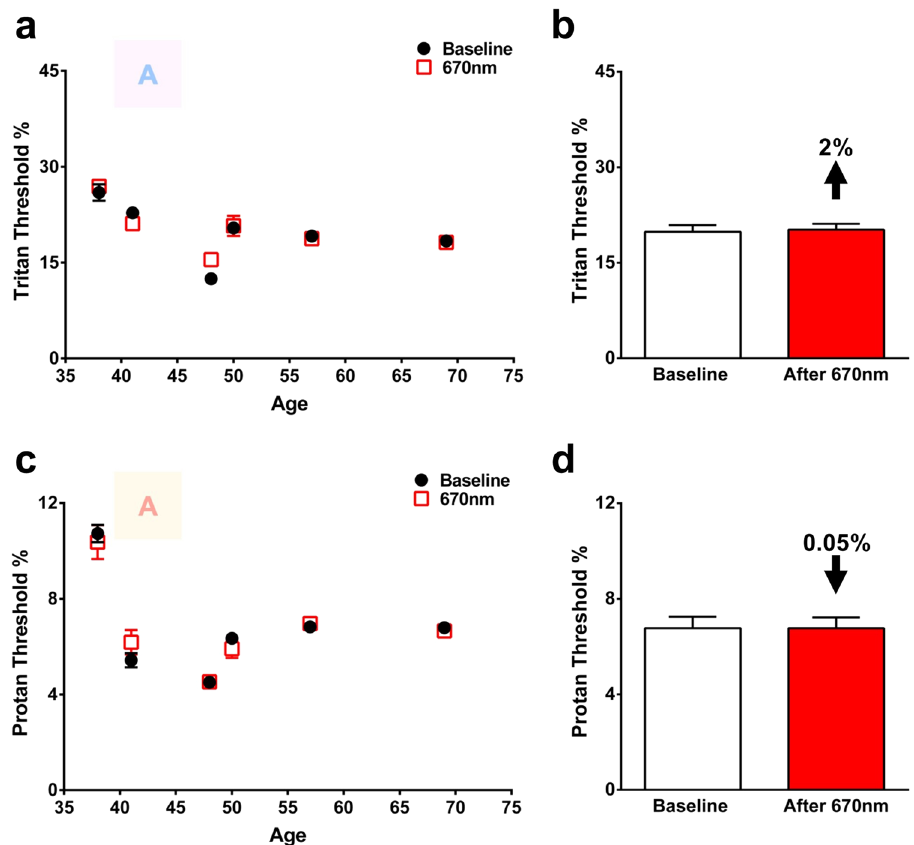
Figure 3. Colour contrast sensitivities measured 3 h following an afternoon exposure (12-1PM) of 670 nm. CCS of tritan ( a ) and protan ( c ) axes measured in 6 healthy subjects and their response to 670 nm exposure. Black closed circles represent baseline measurements and red open boxes are those in the same individuals measured 3 h following a single 3 min 670 nm exposure delivered in the afternoon. The colour letter A in both graphs is an example of the target to be identified as it appeared on the screen. ( b ) Thresholds for tritan function in individuals 38–69 years. No significant change to tritan thresholds (p = 0.3047) were found when subjects were exposed to 670 nm light in the afternoon. ( d ) Thresholds for protan function in individuals 38–69 years. 670 nm exposure showed no effect on protan thresholds (p = 0.2577) when it was delivered in the afternoon. Wilcoxon matched-pairs signed rank test was used for statistical analysis. Data are presented as means ±